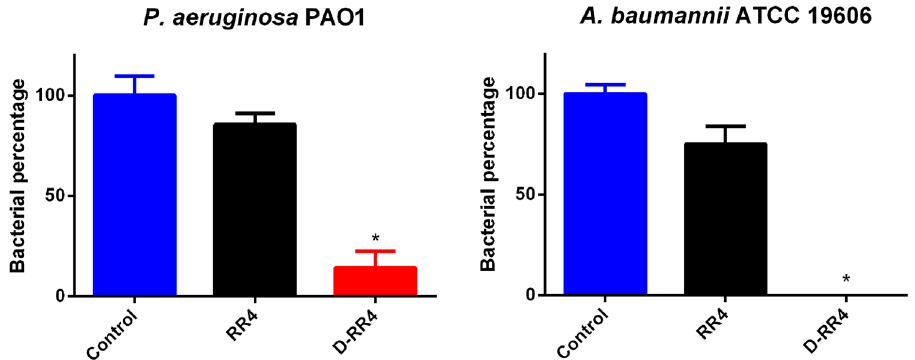
Figure 2. Intracellular antibacterial activity of peptides in infected murine macrophage cells (J774A.1). The effect of RR4 and D-RR4, at 8 × MIC, to kill intracellular P. aeruginosa PAO1 and A. baumannii ATCC 19606 inside infected J774A.1 cells after treatment for 24 hours. Statistical analysis was calculated using one-way ANOVA, with post hoc Tukey’s multiple comparisons test. P < 0.05 was considered significant. One asterisk ( * ) indicates significance from the negative control. Results are expressed as means from three biological replicates ± standard